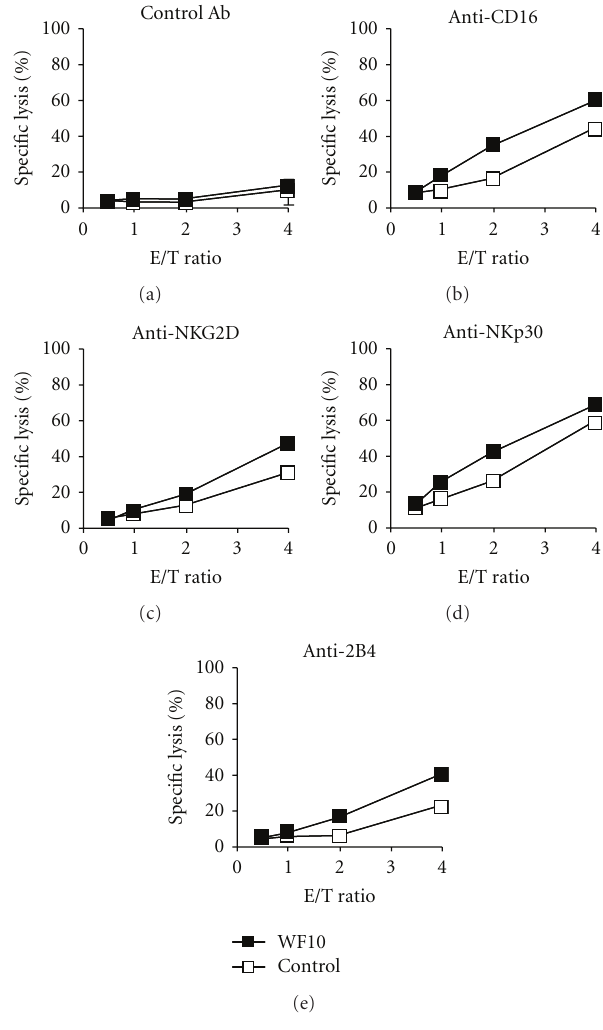
Figure 5: Enhancement of receptor-mediated cytotoxicity of IL- 2-activated NK cells by WF10. IL-2-activated NK cells were tested in a redirected-lysis assay against murine P815 cells. NK cells were stimulated using a (a) control antibody, or by antibodies directed against the activating receptors (b) CD16, (c) NKG2D, (d) NKp30, or (e) 2B4. Where indicated, WF10 was added to the assay medium at a final chlorite concentration of 200 μ M. Average values of triplicates are shown with the standard deviation. One representative of three independent experiments with di ff erent donors is